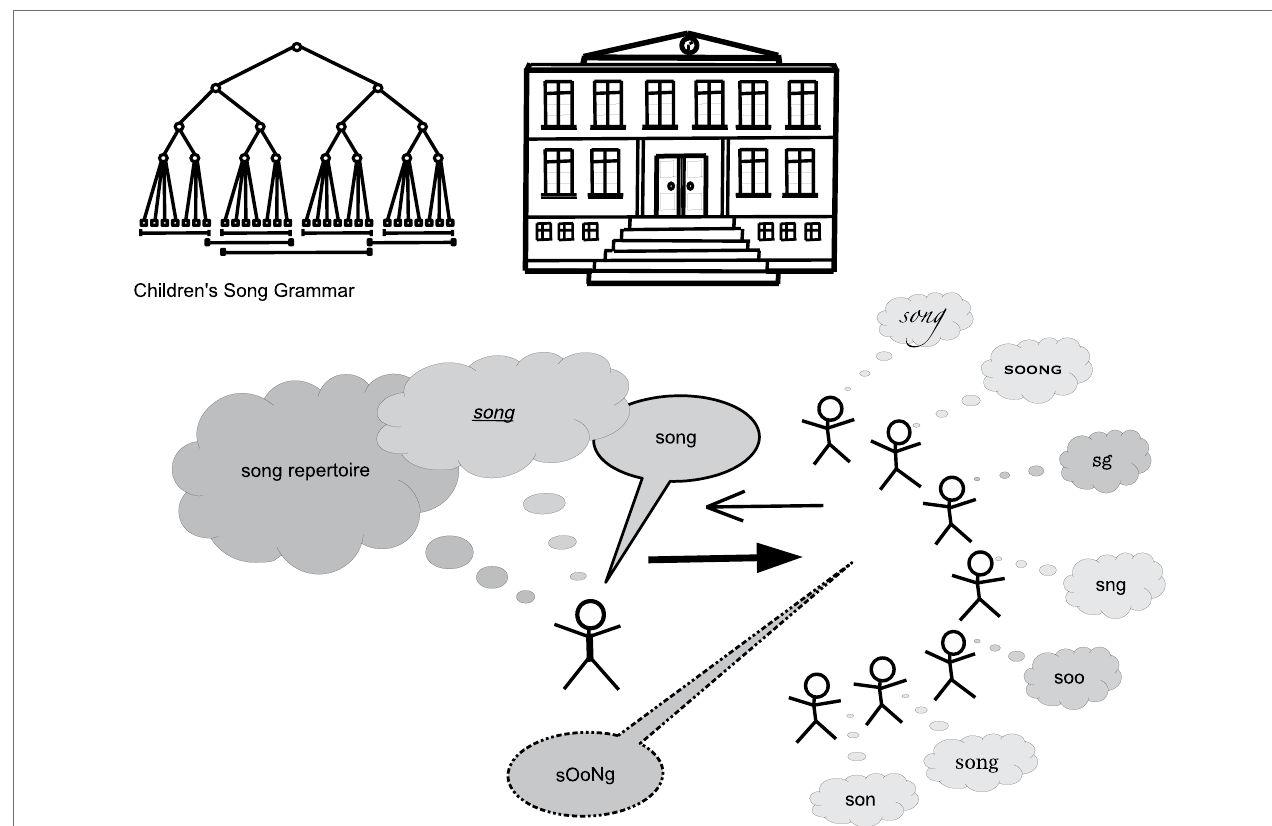
Figure 1 schematizes the process of song transmission. Characteristic of this process is that songs as vocal products are the epitome of an ephemeral event. Whereas the teaching and learning of a new song occurs as a very fast interaction, the researcher must decouple this process from its actual 2 I use the term synphonize according to the Greek meaning to sound together . The term synchronous refers to simultaneity, and the term polyphonic to several voices singing together.